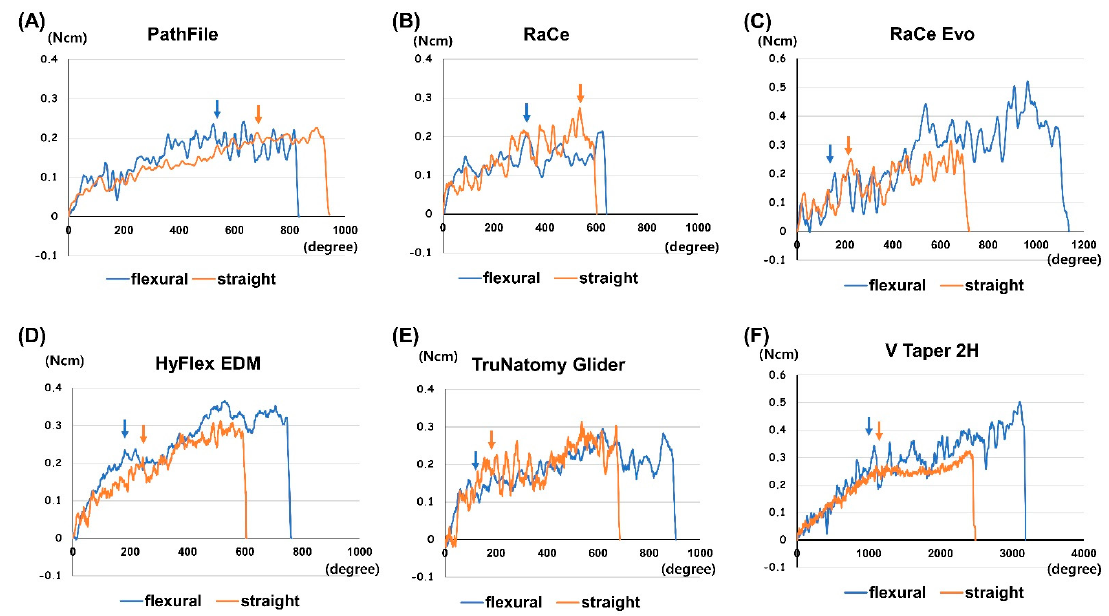
Figure 4. Representative torque (N cm)-angle (degrees) curves from the torsional resistance test. The curves of each file brand were depicted in both straight mode and flexural mode. ( A ) PathFile; ( B ) RaCe; ( C ) RaCe Evo; ( D ) HyFlex EDM; ( E ) TruNatomy Glider; ( F ) V Taper 2H. An arrow indicates elastic limit in each test mode.